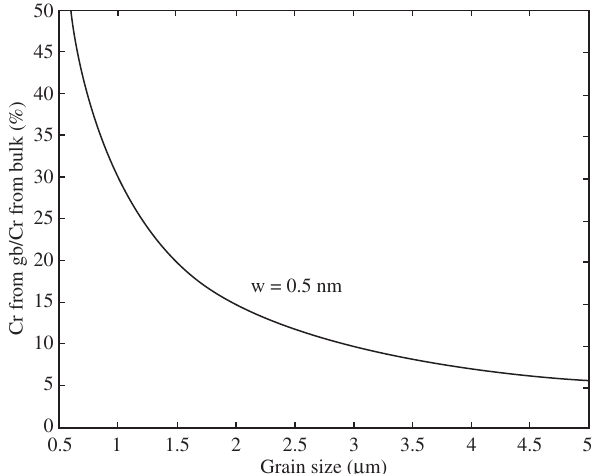
Figure 6. Cr flux along grain boundaries of TP 347 at 750 °C with very small grain size.